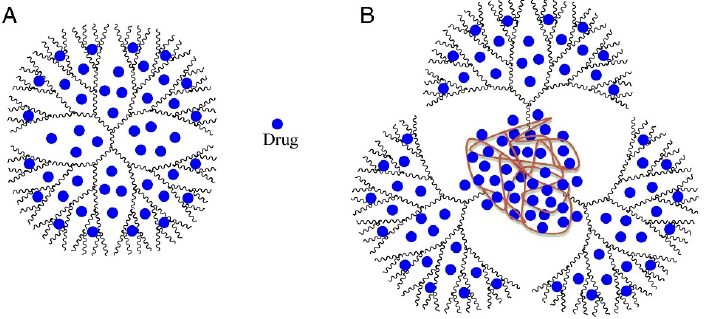
Figure 21. The probable structure of drug-loaded PAMAM dendrimer ( A ); and drug-loaded PPO*PAMAM dendrimer (B). PAMAM—polyamidoamine; PPO*PAMAM—polypropylene oxide cored polyamidoamine. Reproduced from [73], with permission from Elsevier, 2021.